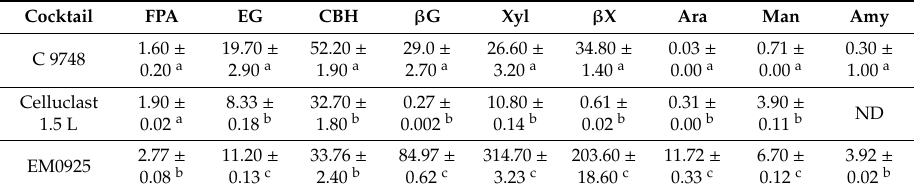
Figure 1. Activities of cellulase and hemicellulase secreted by T. harzianum EM0925 induced by different kinds of lignocellulosic biomass. ( a ) FPA in cultures; ( b ) CMCase activities in cultures; ( c ) hemicellulases activities in cultures. Table 1. Cellulase and hemicellulase activities of EM0925 and commercial enzyme preparations (specific activities, U/mg protein).